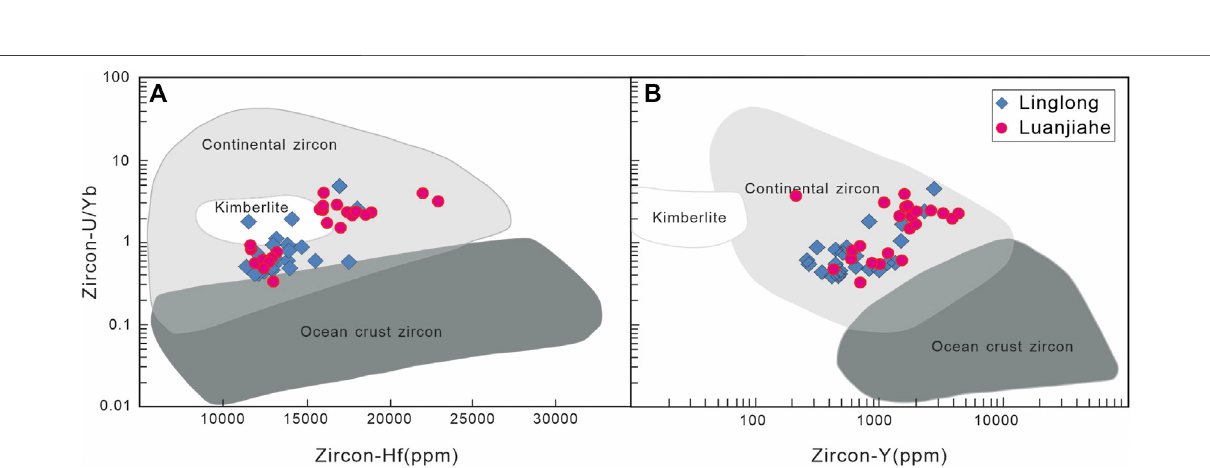
FIGURE 7 | F-Cl-OH ternary diagram (A) and F-OH diagram (B) . The OH content in apatite is calculated based on the assumption that halogen sites are occupied completely with X F + X Cl + X OH = 1, where X is the mole fraction modulus (Piccoli and Candela, 2002).